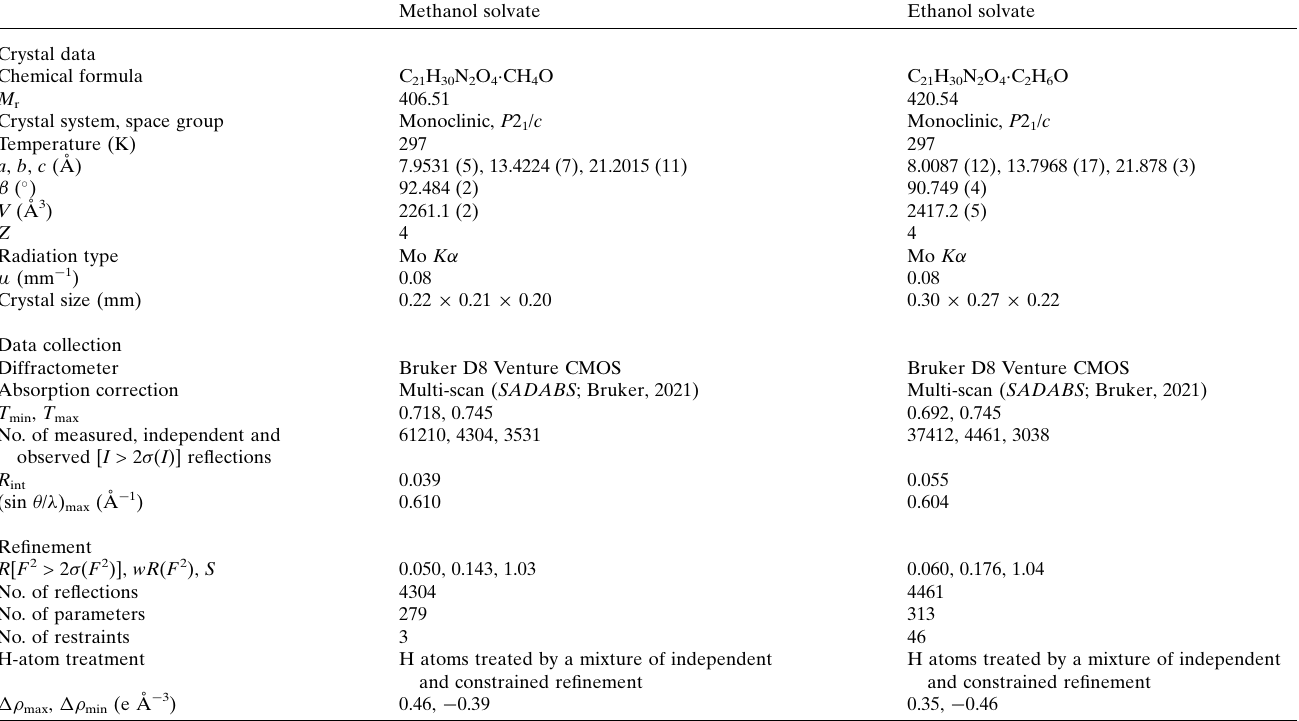
Methanol solvate